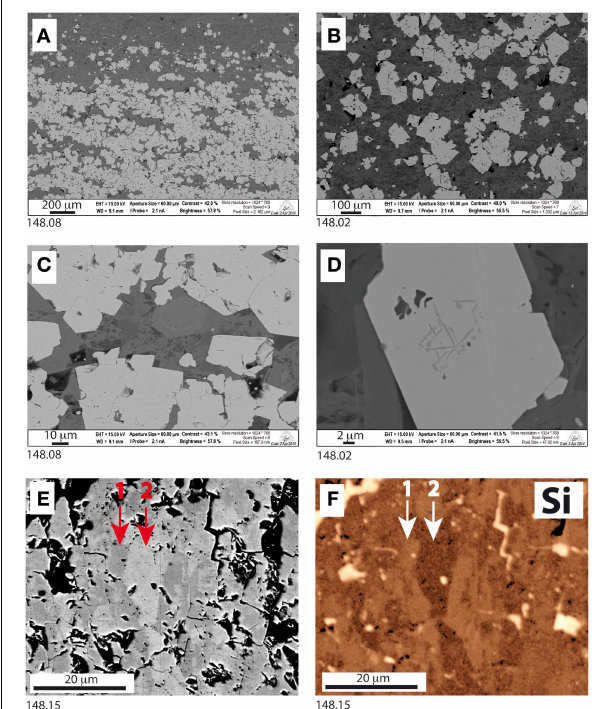
FIGURE 4 | SEM images and elements mapping in samples 148.08 (A,C), 148.02 (B,D) and 148.15 (E,F). (A,B): low magnification images of BIF layers in 148.08 and 148.02. (C) BIF layers in 148.08 at high magnification showing close packed magnetite crystals. (D) : high magnification image of an iron oxide crystal in the cherty part of 148.02 showing lamellar exsolutions in an iron-titanium oxide. (E) Back-scattered electron image of a magnetite crystal in 148.15 with tuned brightness and contrast and (F) corresponding EDX Si elemental mapping. The arrows indicate 2 areas of different compositions (1: Si-rich magnetite and 2: Si-low